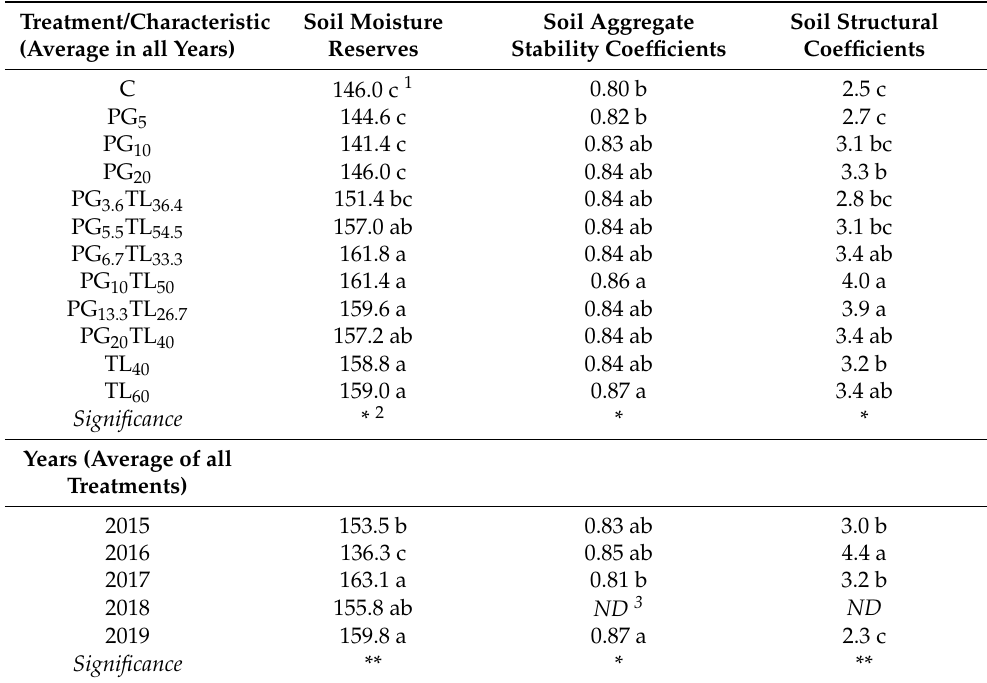
Table 7. Effect of treatments and years on soil water-physical properties/characteristics.